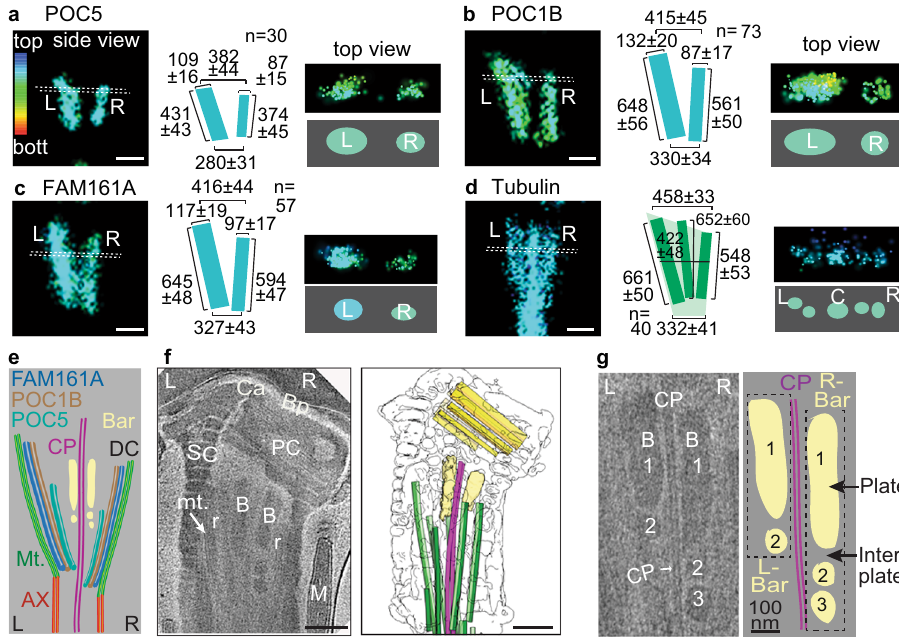
Fig. 2 The DC is asymmetric. a – d Representative 3D-STORM images taken with different rod protein staining. Rod proteins and microtubules are asymmetric in the bovine sperm DC, as observed using 3D-STORM. Side view (left two panels); top view (right two panels). All sizes are in mean ± sd nm. The colors represent depths of 1178 nm in the Z-plane, with red at the bottom (bott.) in all fi gures. Statistics are shown in Supplementary Fig. 2f. Scale bars 200 nm. STORM imaging with all proteins was repeated three times independently with a similar result. e Schematic diagram of a longitudinal section through the DC, showing relative positions of different structures based on 3D-STORM and cryo-ET imaging measurements. f , g A computational slice (left) and corresponding 3D segmentation (right) of a Volta phase plate cryo-tomogram of a bovine sperm neck ( f ). Digital zoom of a cryo-tomogram illustrating bar asymmetry, complexity, and intimate association with the central pair ( g ). The experiment was repeated twice independently with similar results. The labels “ 1 ” , “ 2 ” , and “ 3 ” mark distinct bar plates. Scale bars, 250 nm. C central microtubules, mt. microtubules, r rod, B bars, CP central pair. Source data are provided as Source Data